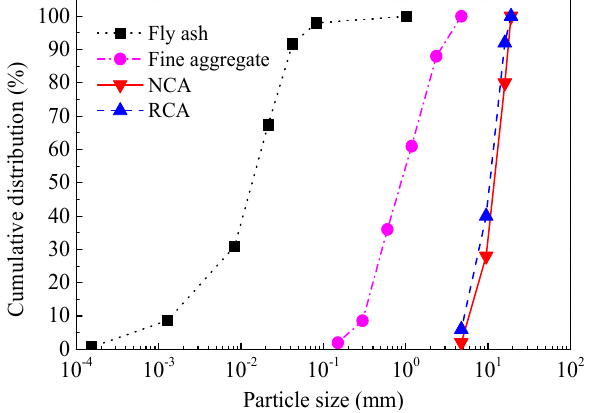
Figure 1. The gradation curves for fly ash, fine aggregate, NCA and RCA. Table 2. Properties of the polycarboxylic Table 1. Mix properties of concrete ( 3 k g m − ⋅ ).